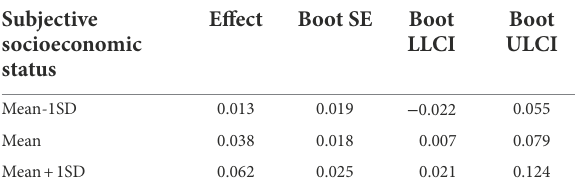
TABLE 4 The mediating effects of subjective well-being between gender role attitudes and work–family conflict at different subjective socioeconomic